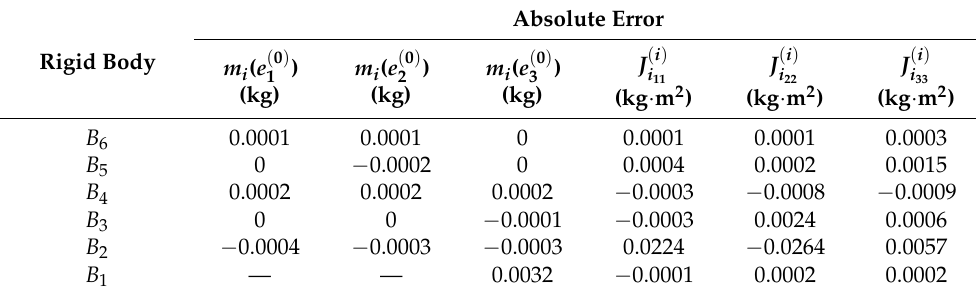
Table 3. The absolute error between the dynamic parameters and their real values.